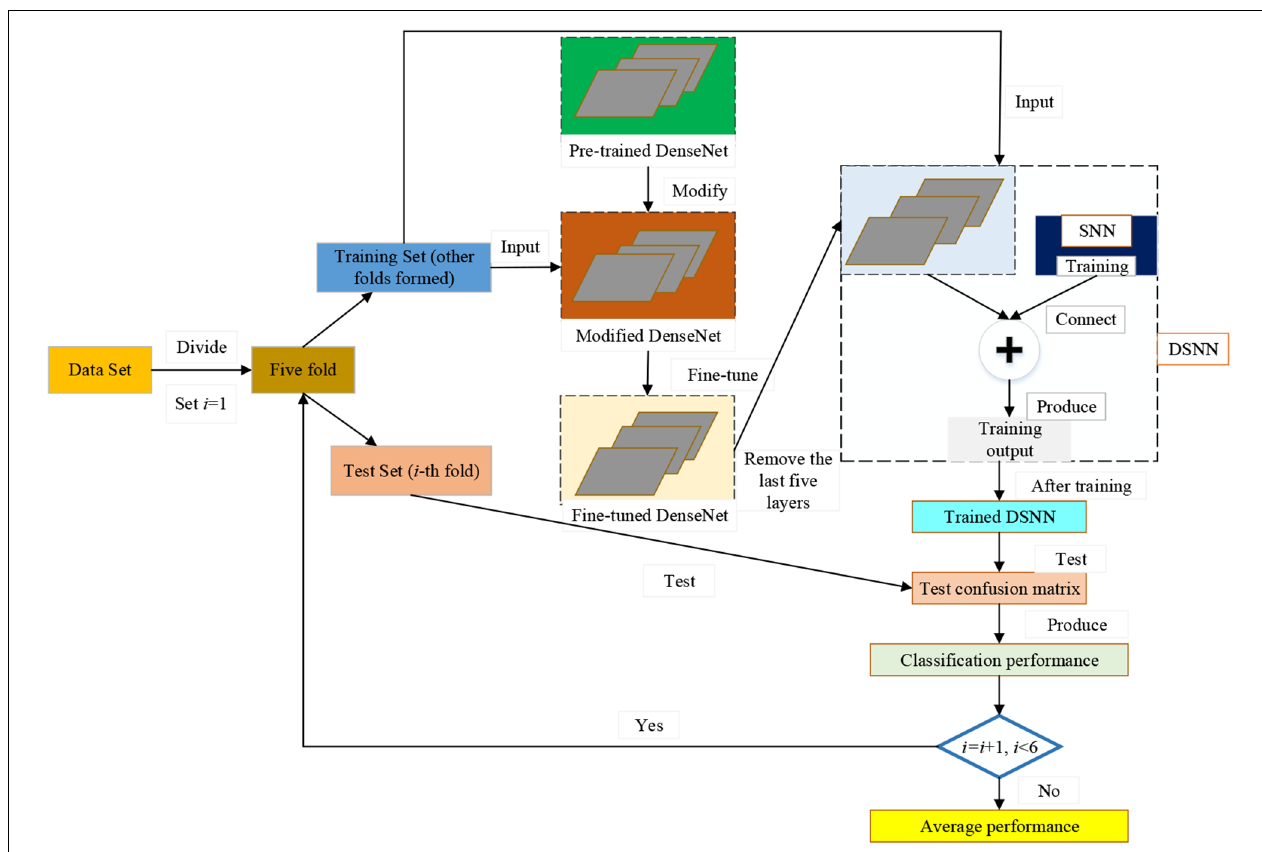
FIGURE 2 | The pipeline of the proposed